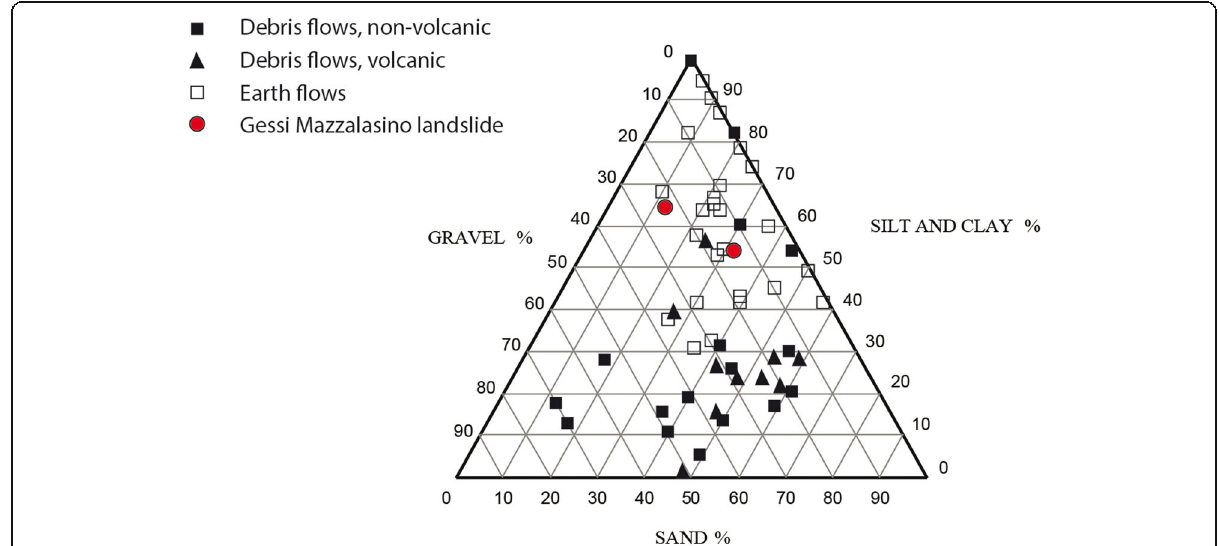
Fig. 7 Ternary plot of the two soil samples with textural classification (from Hungr et al.,